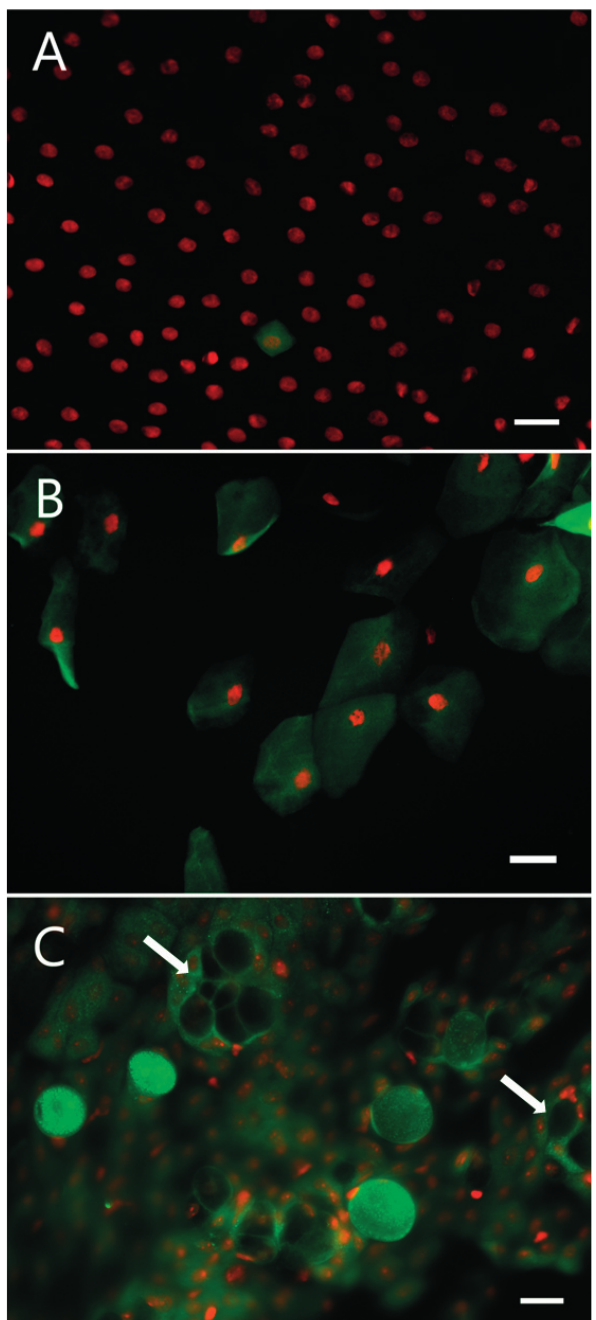
Fig. 1. The morphological differences of the ocular surface cells: epithelial cells with a nucleus-cytoplasm ratio of 1:2 to 1:4 (A), squamous cells with a nucleus-cytoplasm ratio of 1:5 or lower (B), goblet cells (arrows) (C). Green fluorescence of apoptotic cells after anti-active caspase 3 antibody immuno- chemical detection, scale bar represents 50